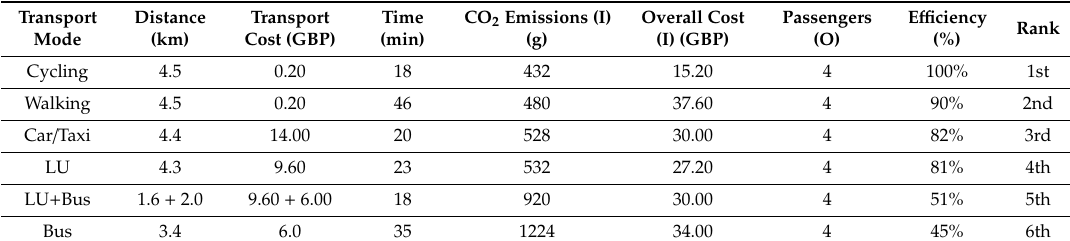
Table 4. Route B. Results in descending order of efficiency of the transport modes DEA model. Transport Table 5. Route B with 4 passengers. Results of e ffi ciency of the transport modes DEA